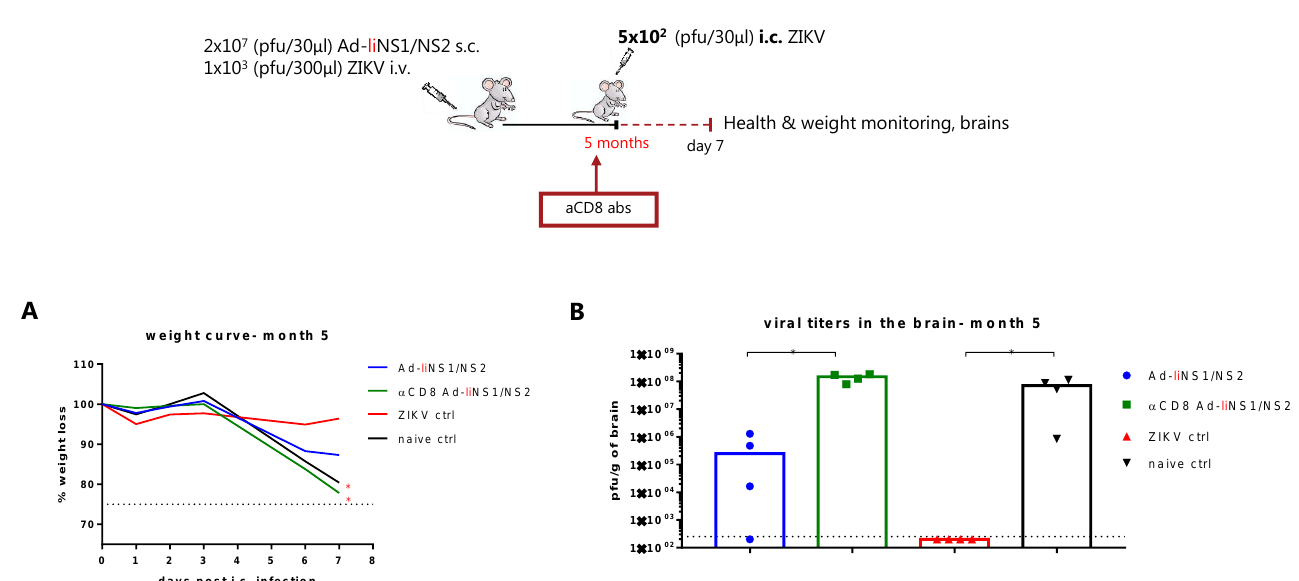
Figure 6. Role of CD8 T cells in long-term protection from the Ad-ZIKV liNS1/NS2 vaccine. WT C57BL/6 mice were vaccinated s.c. with 2 × 10 7 pfu of Ad-liNS1/NS2 and five months later, mice were depleted of CD8 T cells ( α CD8-Ad- liNS1/NS2) prior to i.c. challenge with 5 × 10 2 pfu ZIKV. A group of vaccinated, undepleted mice along with ZIKV-immune and naive mice were included for comparison. ( A ) All groups were weighed and monitored daily following i.c. challenge. ( B ) On day 7 post i.c. challenge, brains were removed and viral titers were determined by a standard plaque assay. The detection limit for virus in brain was 250 pfu/g organ and is displayed as a stippled line. Each dot represents an individual animal. The columns represent the group medians. * p < 0.05. For the weight curves, error bars have been omitted for clarity, instead, stars denote a statistical significant difference compared to the unvaccinated control